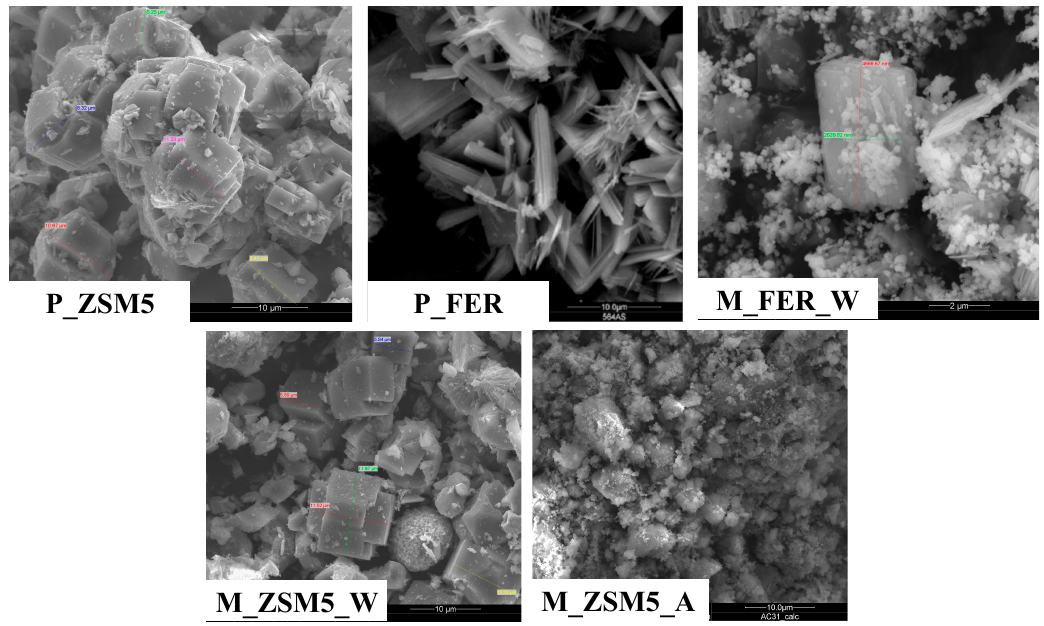
Figure 1. SEM images for parent and hybrid samples.